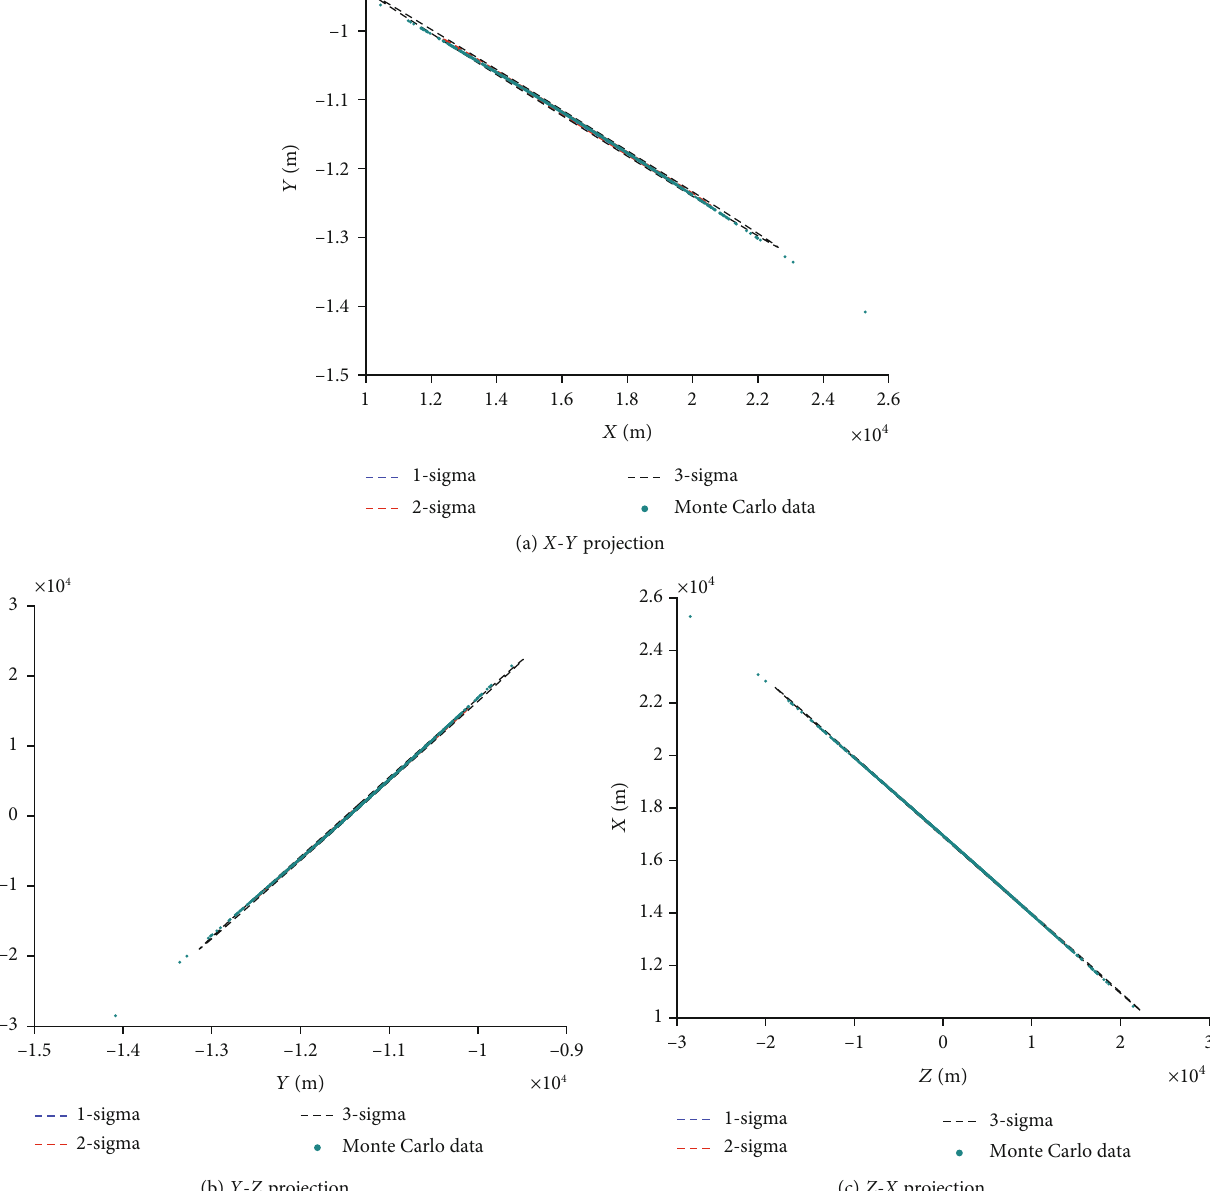
Figure 11: Error ellipsoid projection of Monte Carlo simulation results in the Mars model varying